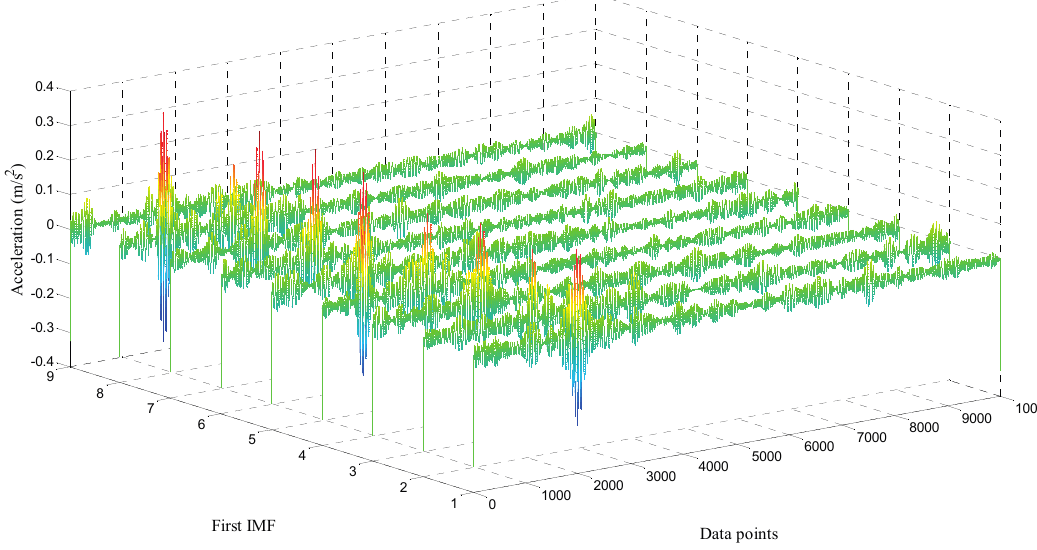
Figure 10. Profile of the collection of first IMFs from damaged bearing acceleration: 10